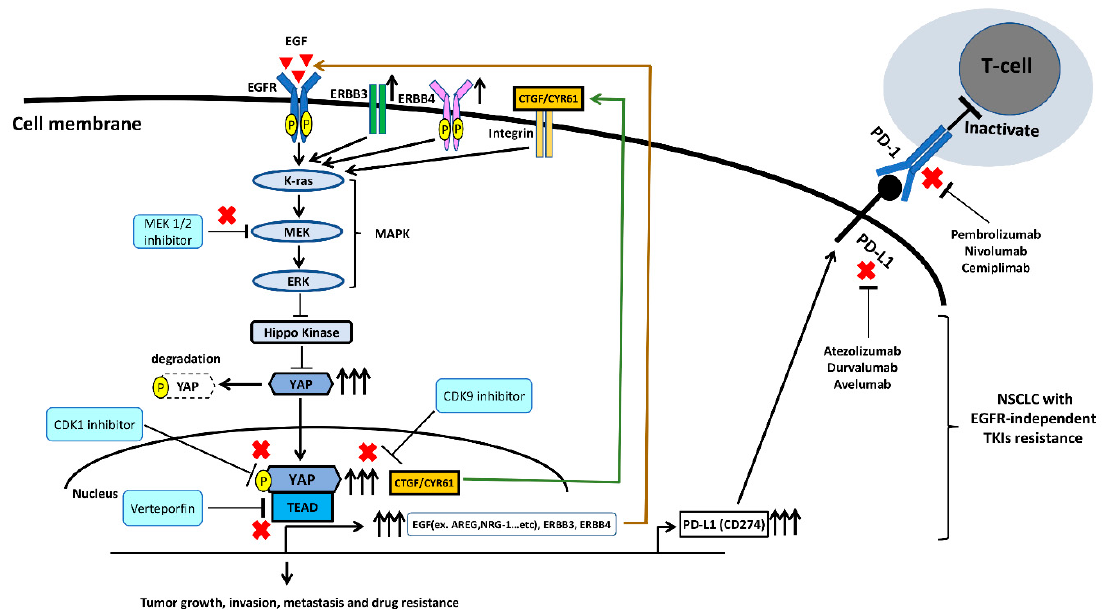
Figure 4. In EGFR mutant NSCLC without targetable resistant mutations, activation of YAP enhances the downstream genes expression of EGFs, ERBB3, ERBB4, CTGF, and CYR61 to form an autocrine loop and reinforce MAPK signaling pathway to induce cancer progression, drugs resistance, and immune escape. YAP blockade by MEK 1/2, CDK1, CDK9, and YAP-TEAD complex inhibitors in combination with anti-PD-1/PD-L1 ICIs may be a future therapeutic strategy for the treatment of EGFR mutant NSCLC without targetable resistant mutations.